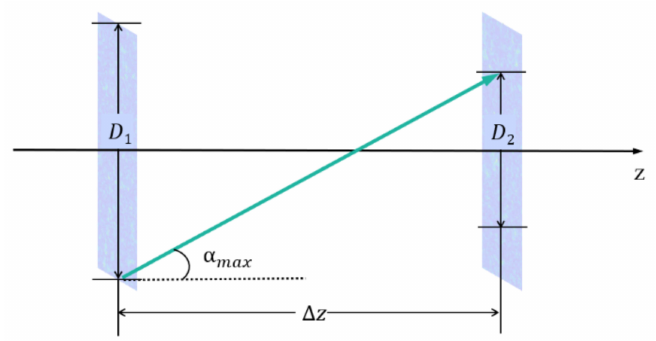
Figure 2. Schematic diagram of the geometric relationship in the diffraction